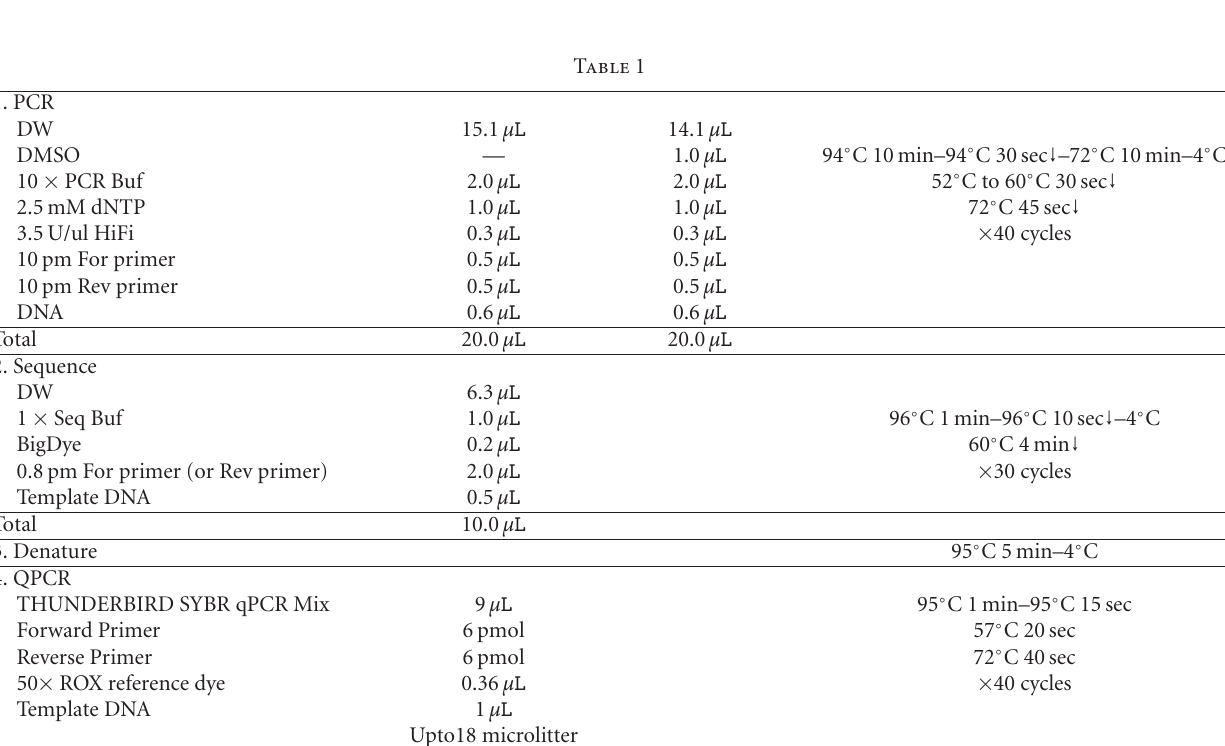
(vii) Levodopa response for 5 years or more. (viii) Clinical course of ten years or